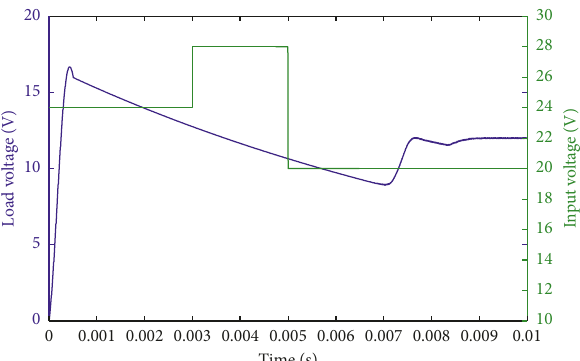
Figure 10: Output current and voltage for varying input voltage for ZN-PID controller.